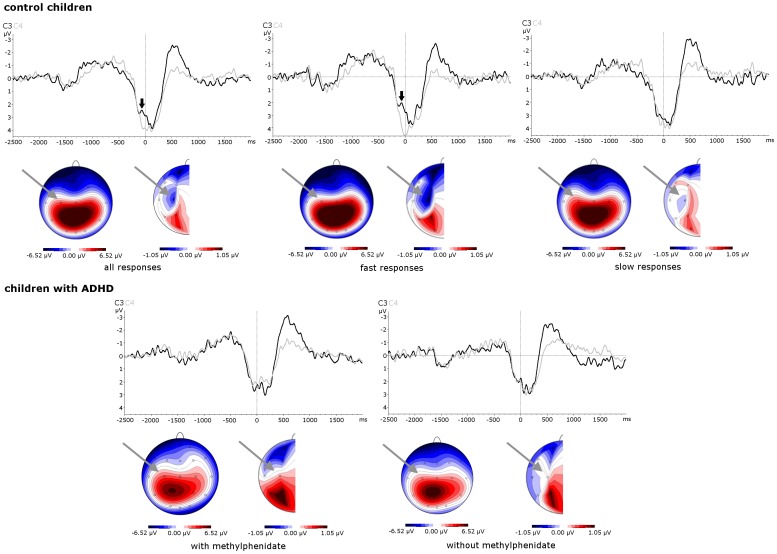
Time-course and topography of response-locked movement-related potentials (initial movement related potential peak - iMP) including the topography of iMP lateralization ([C3−C4]/2).For control children, averages of all responses are illustrated together with a separate presentation of averages of fast (below median reaction time) and slow responses (above median reaction time). For children with ADHD, responses on and off methylphenidate are presented. For effects of response speed in ADHD see Figure 4. Note how the rather symmetrically distributed stimulus-related P300 shadowed MRP in the topography before the subtraction of symmetrically distributed potential components by the calculation of lateralization. iMP time-course (thick black arrows) and lateralized topography around C3 (grey arrows) are in good agreement with previous literature. mPINV (lateralized negativity at C3 in the time interval 500–800 ms) was not shadowed by P300 any more. Its topography is presented in Figure 2.